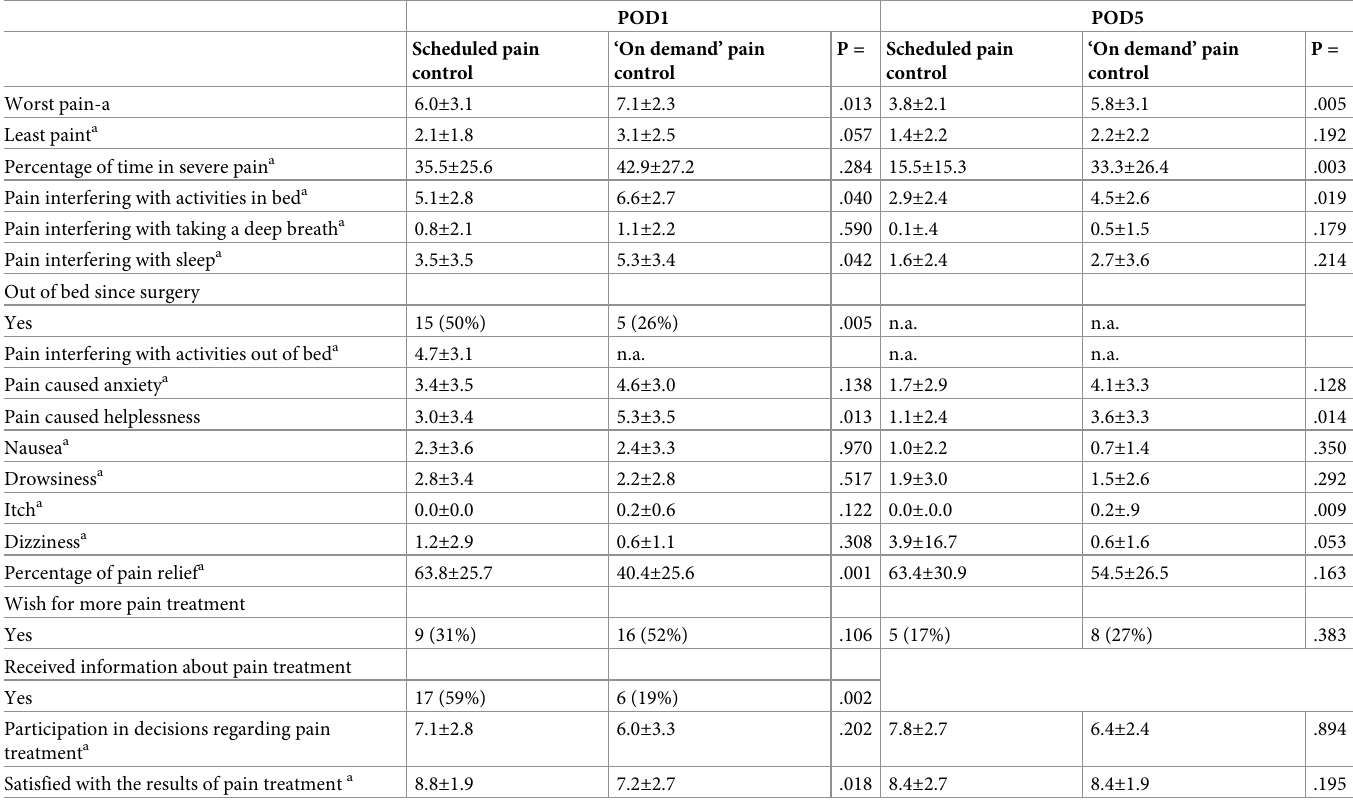
Table 3. Patient reported outcomes on POD1 and POD5 in the two groups.